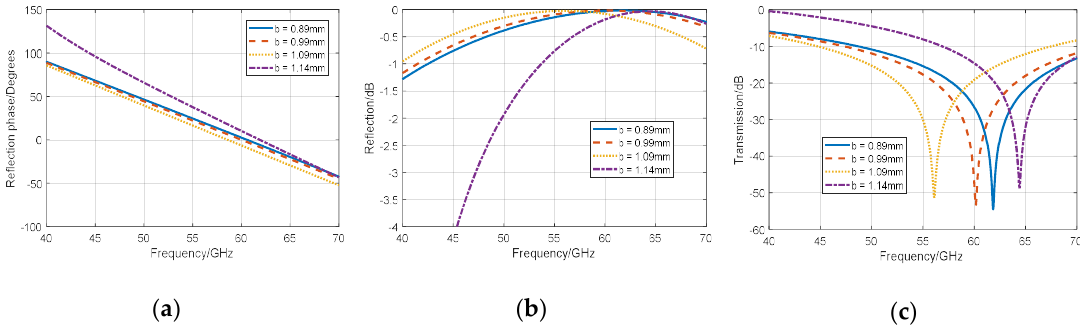
Figure 7. Reflection phase, reflection coefficient and transmission coefficient of the dual loop metasurface at the varied inner radius, ‘b’: ( a ) Reflection phase, ( b ) reflection coefficient and ( c ) transmission coefficient.